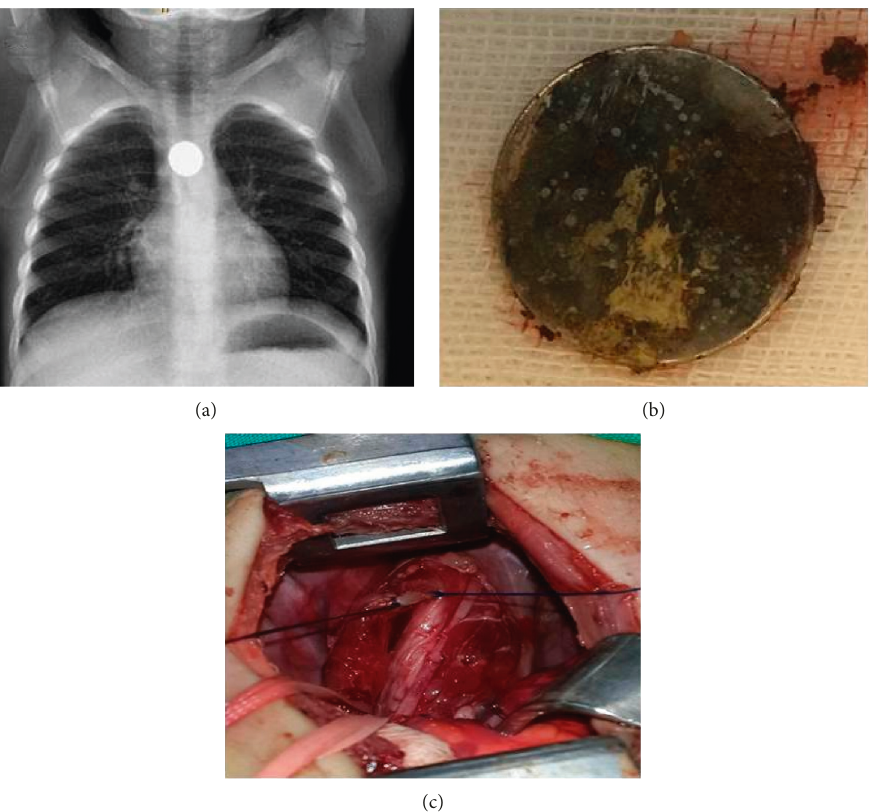
Figure 1: Images from a 2-month-old boy who was admitted to the hospital 40 days after ingesting a button battery. (a) Anteroposterior chest X-ray with double-contour aspect of the battery lodged in the proximal esophagus. (b) Battery after endoscopic removal. (c) Surgery due to development of a tracheoesophageal